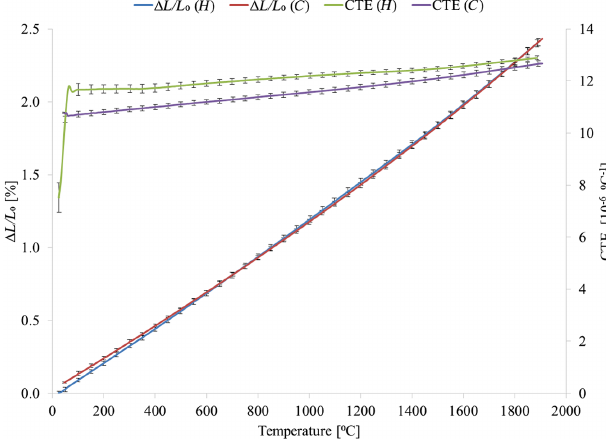
FIG. 14. Relative change in length and CTE against temper- ature with initial thermal reference of 100 . 1 °C ( H ) and 42 . 9 °C ( C ) for CFC along ( T